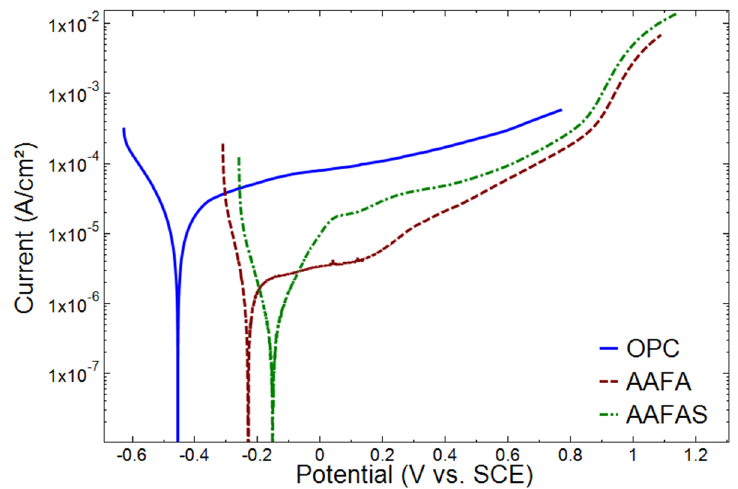
Figure 9. Potentiodynamic polarization (PDP) curves of steel reinforcement embedded in OPC, AAFA, and AAFAS mortars exposed to carbonation for 21 days (1% CO 2 , 66% rH). The PDP data (Figure 9) indicate the corrosion potential of steel samples embedded in OPC (-0.46 V vs. SCE), AAFA ( − 0.22 V vs. SCE), and AAFAS ( − 0.18 V vs. SCE) concretes after accelerated